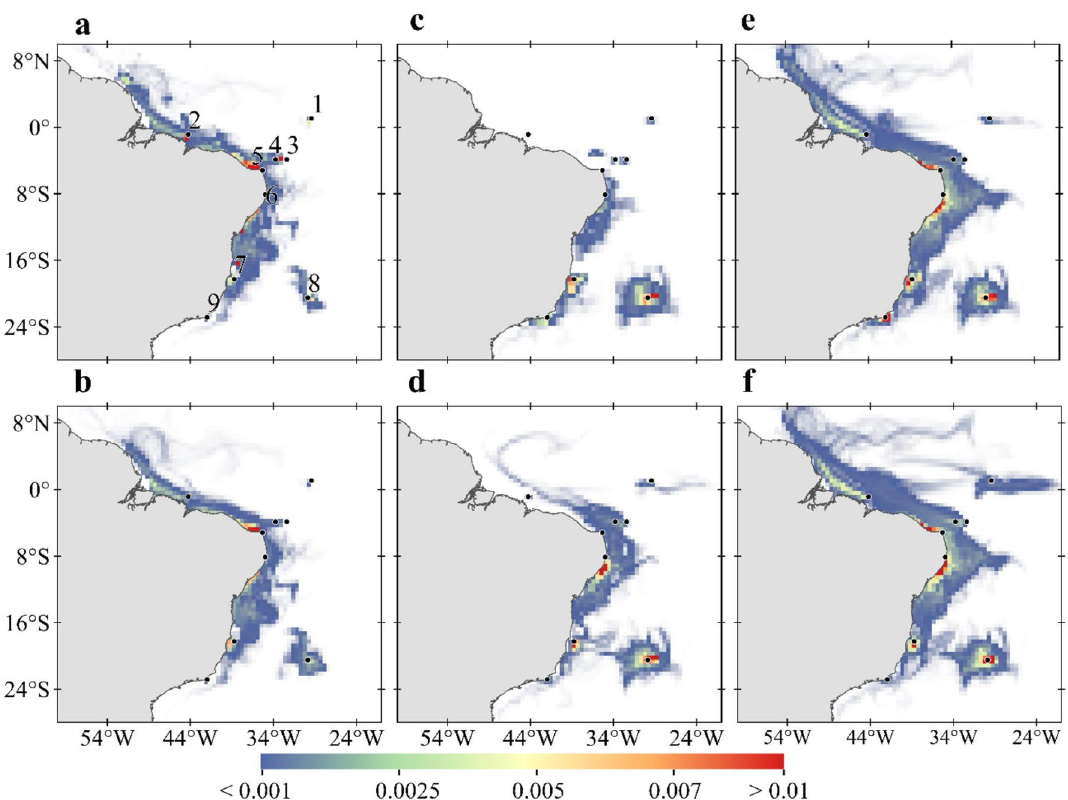
Figure 5. Spatial distribution of total surviving larvae during all experiments. ( a ) Summer and ( b ) winter based on present-day simulation (2008 to 2015). ( c ) Summer and ( d ) winter for RCP 8.5 (2092 to 2100) considering present-day thermal tolerance. ( e ) Summer and ( f ) winter considering acclimation of + 3 °C in RCP 8.5 scenario. Warm colours represent regions with the highest density of larvae along the simulations. Black dots represent MPA locations as in Fig. 1. Created with Matlab R2019a (www. mathw orks. com) and QGIS-3.4 (https:// www. qgis. org).